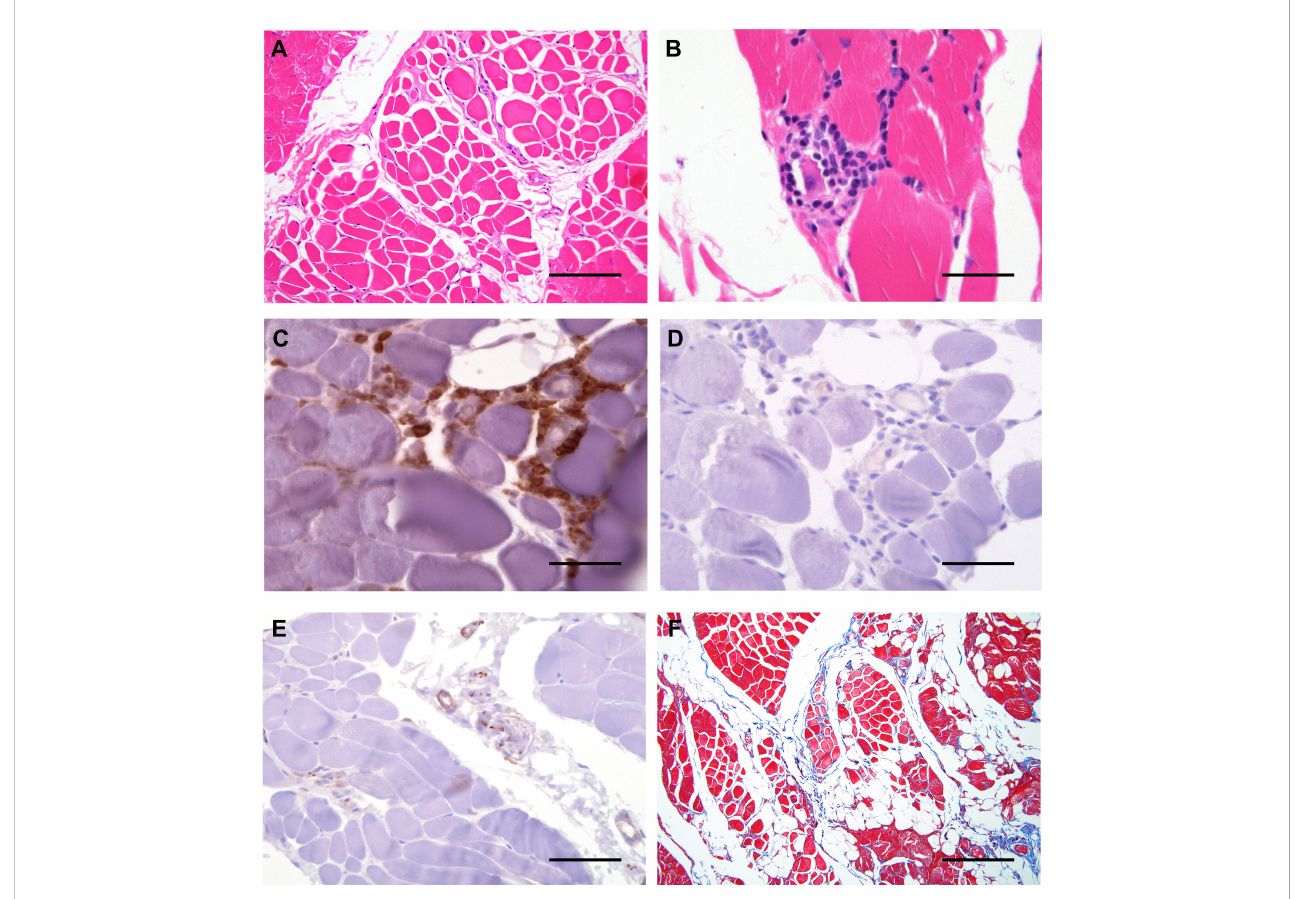
FIGURE 3 Histological features of affected muscle in our patient. (A) Cross sections of H&E staining of skeletal muscle revealing variation in the diameter/caliber of the skeletal muscle fi bers with focal in fi ltrate of the mature adipose tissue. (B) High magni fi cation view of H&E staining of skeletal muscle revealing focal lymphocytic in fi ltrate surrounding a degenerate muscle fi ber, consistent with myositis. (C) Double immunostaining with CD4 (brown) and CD8 (red) depicting lymphocytic in fi ltration by CD4 + T lymphocytes. (D) Immunostaining with CD20 showing no B lymphocyte in fi ltration. (E) Immunostaining with CD56 staining depicting CD56 + N-CAM fi bers. (F) Masson-Trichrome stain highlighting focally increased collagen between the smooth muscle bundles. Scale bars, 2 m m (A, E) , 6 m m (F) or 200 m m (B – D)